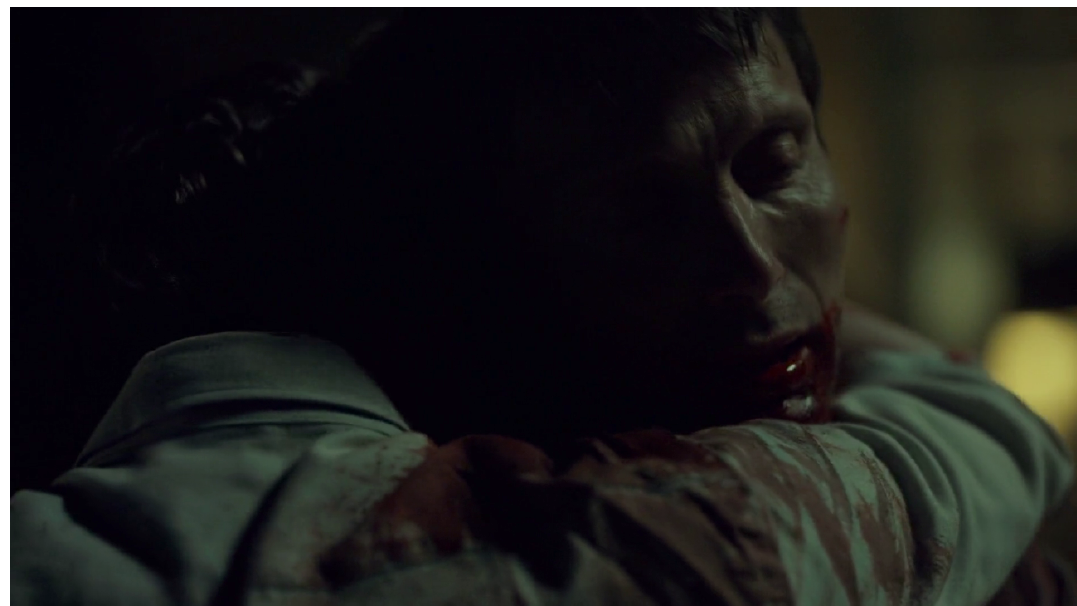
Figure 11. The split second before Will pushes Hannibal off the cliff. The yellowish light on the right (corresponding to the alchemical stage of citrinitas) is dominated by greenish hues. This is not the beginning of a new cycle, but rather a devolution into its initial phases. Screencap from the thirteenth (and final) episode of season 3, “The Wrath of the Lamb.”